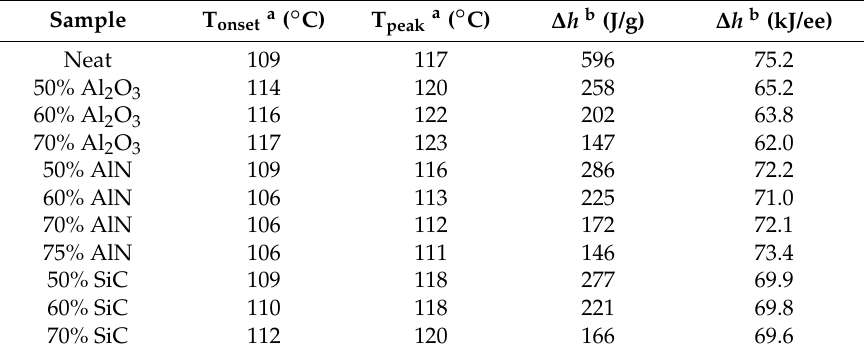
Table 1. DSC data of the different formulations